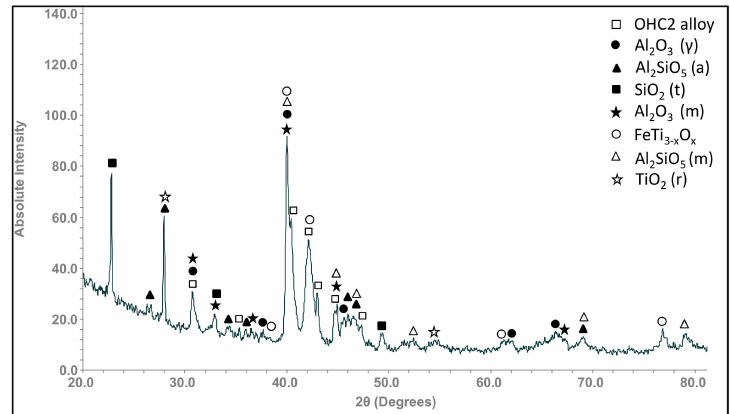
Figure 9. GXRD data ( θ = 5 ◦ ) for the scale formed on the alloy OHC2 at 800 ◦ C for 100 h.